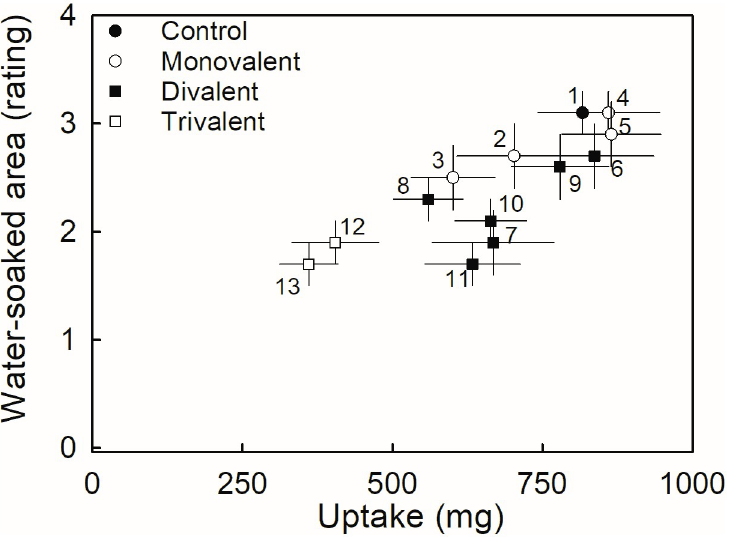
Fig 4. Relationship between water soaking and water uptake of ‘Florentina’ strawberry as affected by the chlorides of various cations. Fruit were incubated in chlorides of monovalent (NaCl (2), KCl (3), NH 4 Cl (4), LiCl (5)), divalent (MgCl 2 (6), CaCl 2 (7), CuCl 2 (8), MnCl 2 (9), SrCl 2 (10), BaCl 2 (11)) or trivalent cations (FeCl 3 (12), AlCl 3 (13)). Deionized water (1) served as control. The coefficient of correlation was r = 0.80 ���